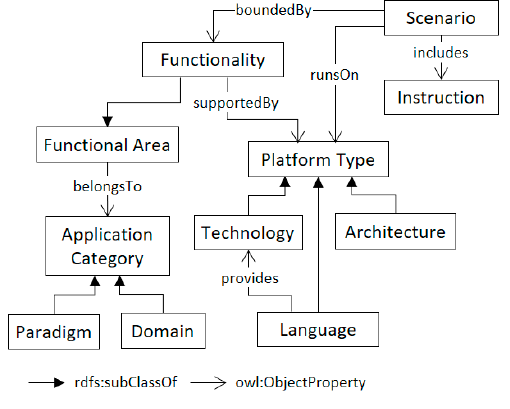
Figure 2. Application Context Model.